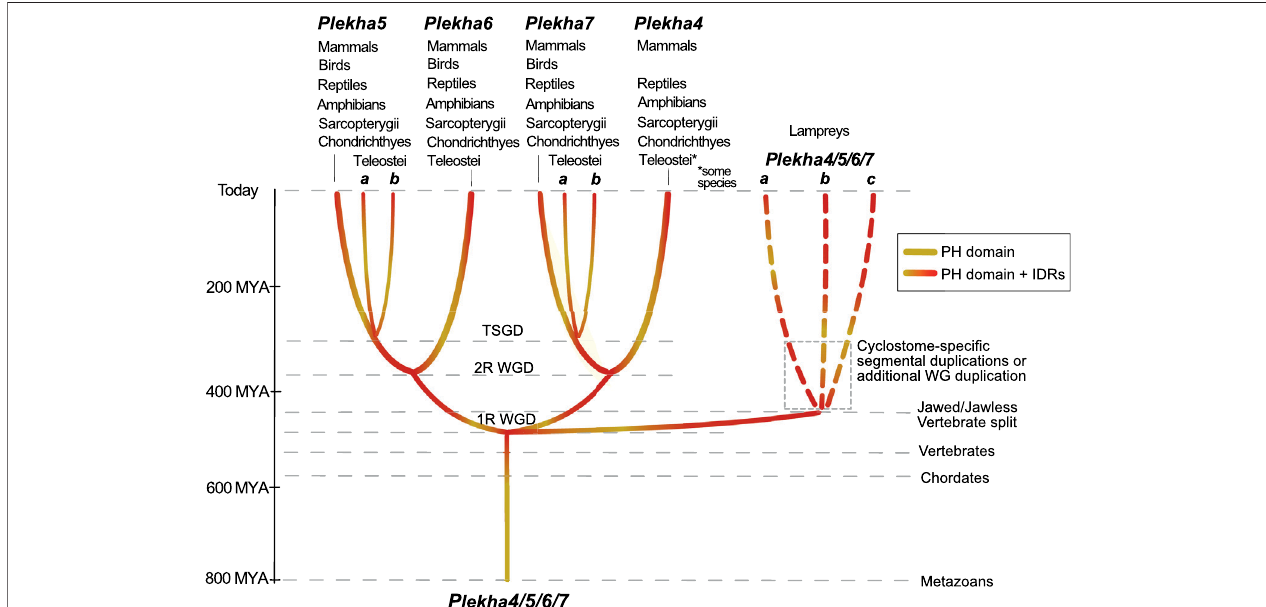
FIGURE 8 | Hypothetical scenario depicting the evolutionary history of the Plekha4/5/6/7 protein subfamily in metazoans. A PEPP1-type PH domain acquired intrinsicallydisorderedregion(IDR)domainsearlyinchordateevolution,inthelastcommonancestorofallvertebrates,andsubsequentlyunderwentgeneduplications.In jawed vertebrates, a fi rst gene duplication gave rise to the Plekha4/7 and Plekha5/6 ancestral genes and a second duplication to the four modern Plekha4,5,6,7 genes. Theseduplications are consistentwith the vertebrate 1R and 2R whole genome duplications (WGD) hypothesis. An additional gene duplication consistent with the Teleost-speci fi c whole-genome duplication (TSGD), resulted in Plekha7 and Plekha5 having two copies in these species (a and b). In parallel, gene duplications that occurredindependently injawless vertebrates,potentiallydue tocyclostome-speci fi csegmental duplications or additional whole-genome(WG) duplication, gave riseto three genes in lampreys that we name Plekha4/5/6/7a,b,c . Approximate timeline of events is shown on the left and with parallel dotted lines, indicating major events throughout metazoan evolution. Taxa names atop each of the four Plekha4,5,6,7 genes refer to their presence in extant jawed vertebrate species from those taxa.